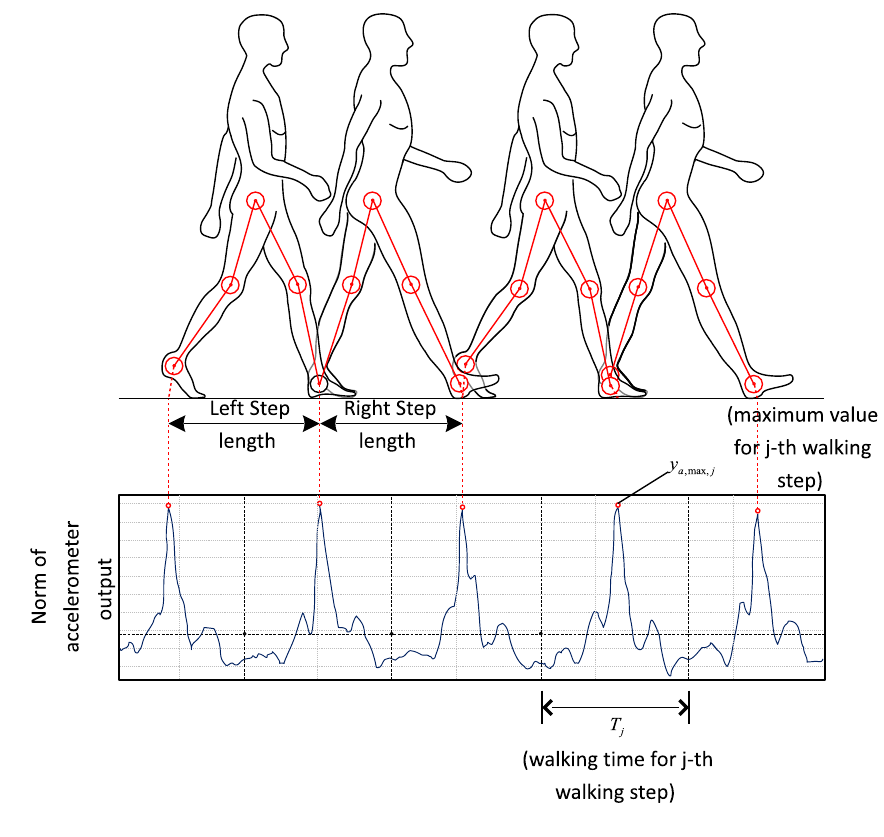
Figure 5. Norm of accelerometer output during